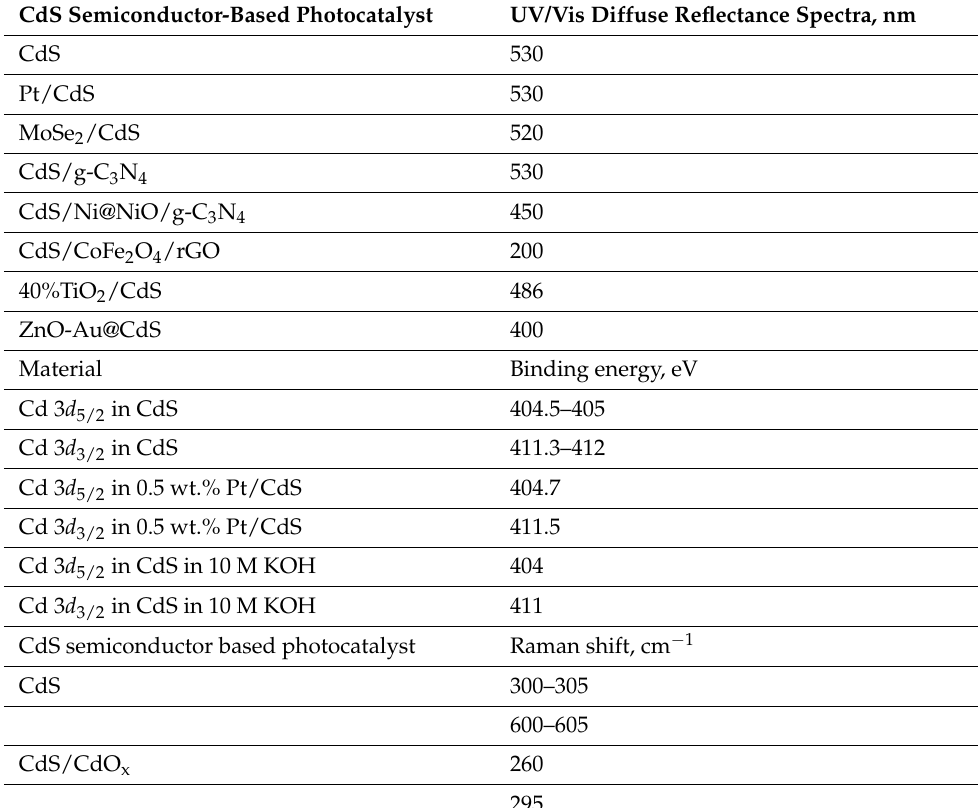
Table 2. CdS-based photocatalytic system analytical characteristics.